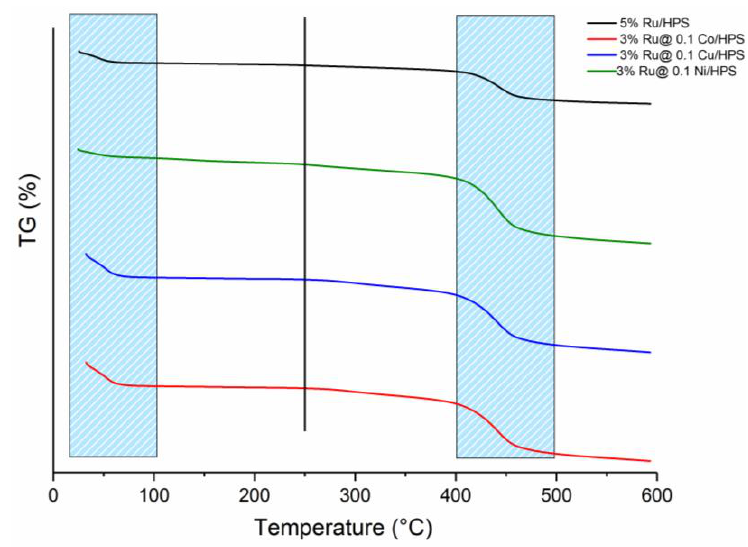
Figure 1. Ruthenium and doped ruthenium/HPS catalysts thermogravimetric profiles. The catalysts' FT-IR spectrums are compiled in Figure 2. It is possible to verify a similar profile for every sample, with bands between 3100–2900 cm − 1 and 1600–1400 cm − 1 typical of bond stretching for sp 3 C-H and C-C, as well as vibration and folding for C-H bonds, all of which are associated with the polymeric matrix of HPS.